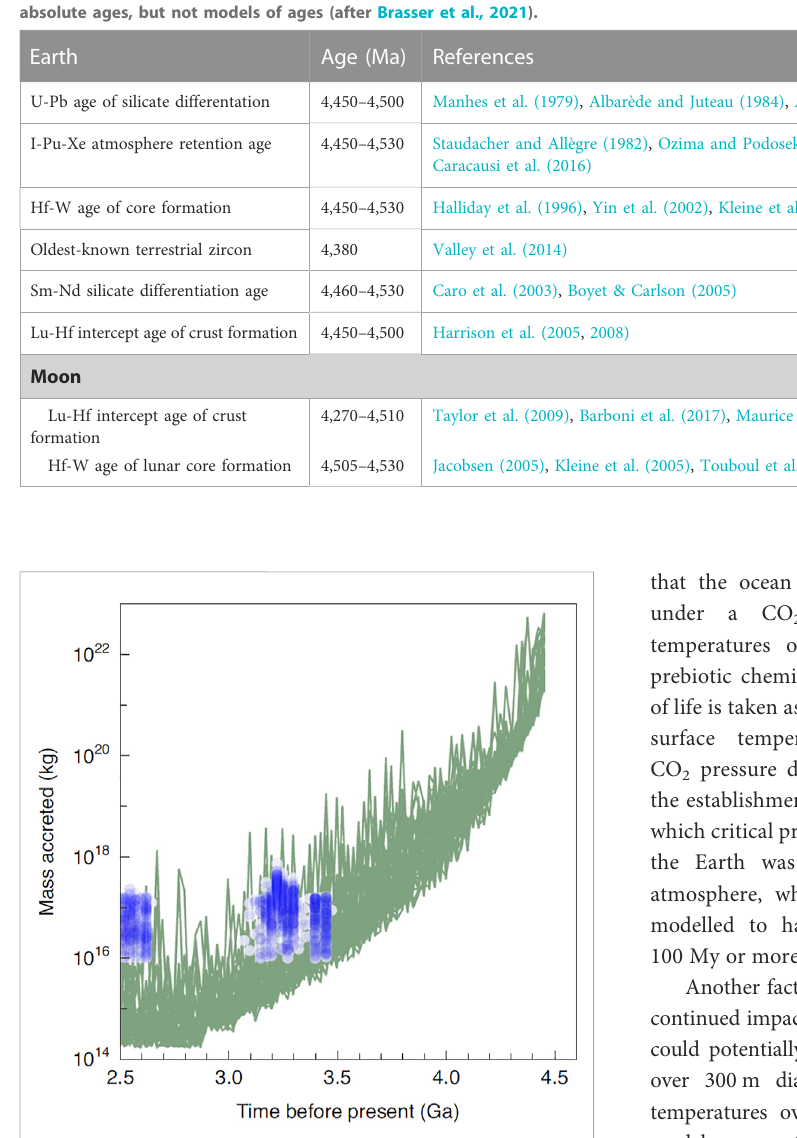
FIGURE 1 Earth ’ s collisional history based on modelling with the dates ofArchaeanimpactspherulelayersadded(blue)(afterMarchietal.,